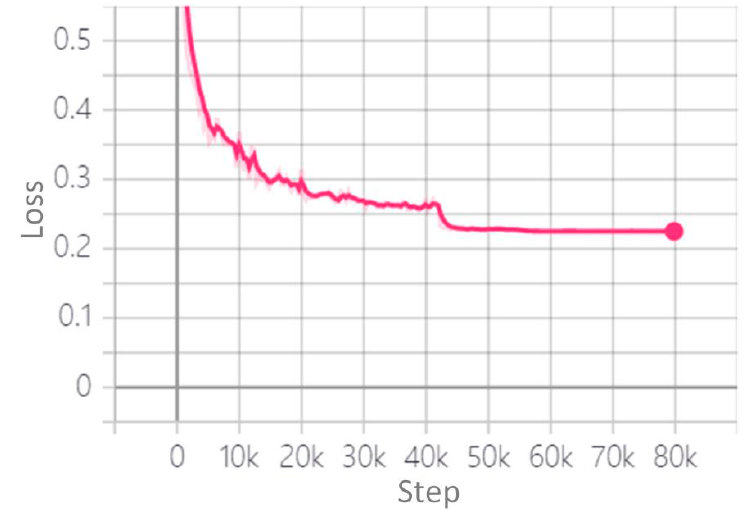
Figure 5. Variation trend of total loss value.